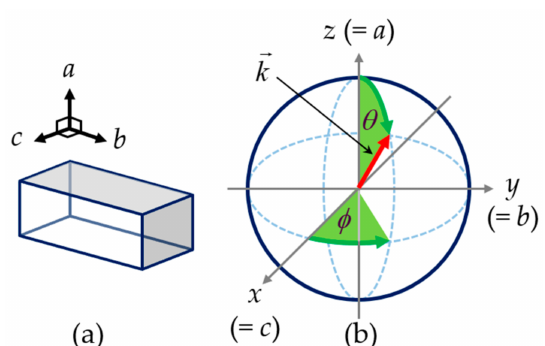
Figure 1. ( a ) A unit cell of Pna 2 1 -BMBF crystal with a point symmetry of orthorhombic mm2. a , b , and c denote the crystallographic axes, and they are all perpendicular to each other. ( b ) A schematic diagram showing the definition of the crystallographic and optical axes in a spherical coordinate, → k ) representing the direction of beam propagation is also defined. φ and θ are where the wave vector ( the azimuthal and polar angles,